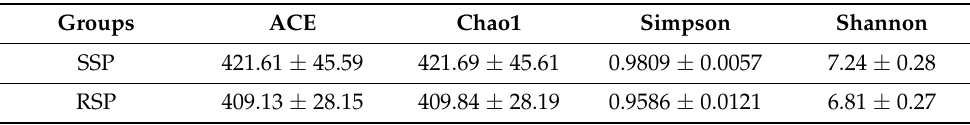
Table 3. Fungal diversity indices in different groups. Groups ACE Chao1